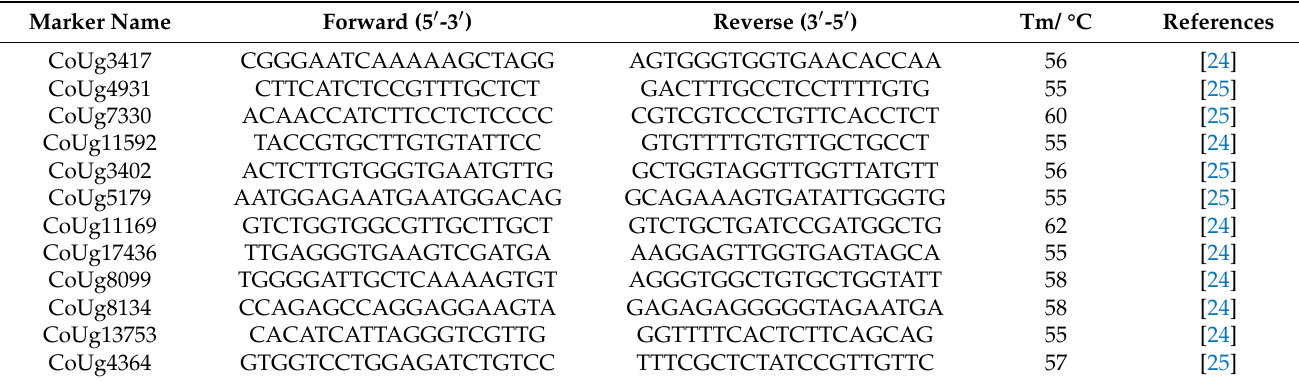
Table 2. SSR primers and sequence